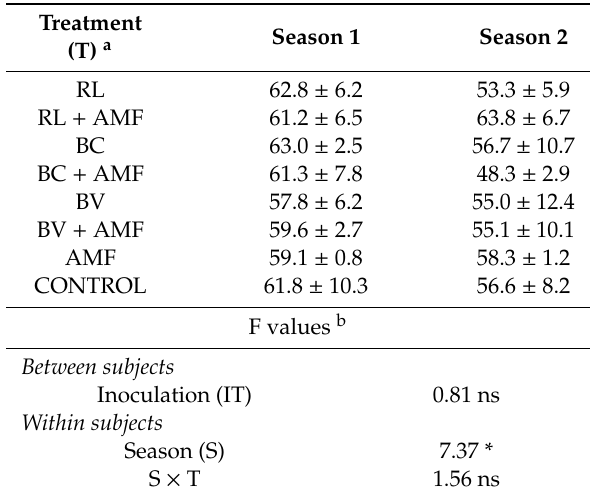
Table 1. Biological nitrogen fixation (% Ndfa) in fava bean roots, using broccoli as a non-N 2 -fixing reference plant. Values are mean ± standard deviation ( n =